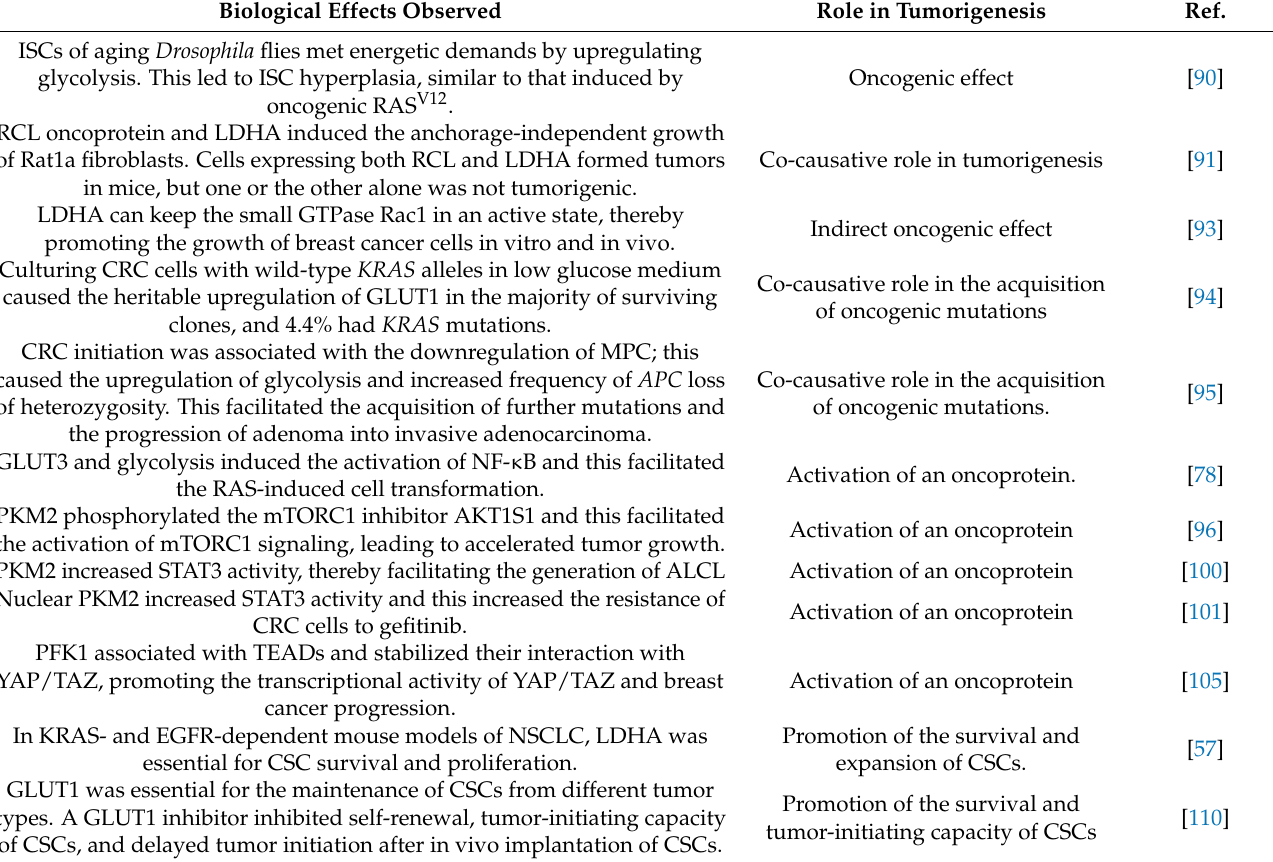
Table 1. Evidence for a causative role of glycolysis in